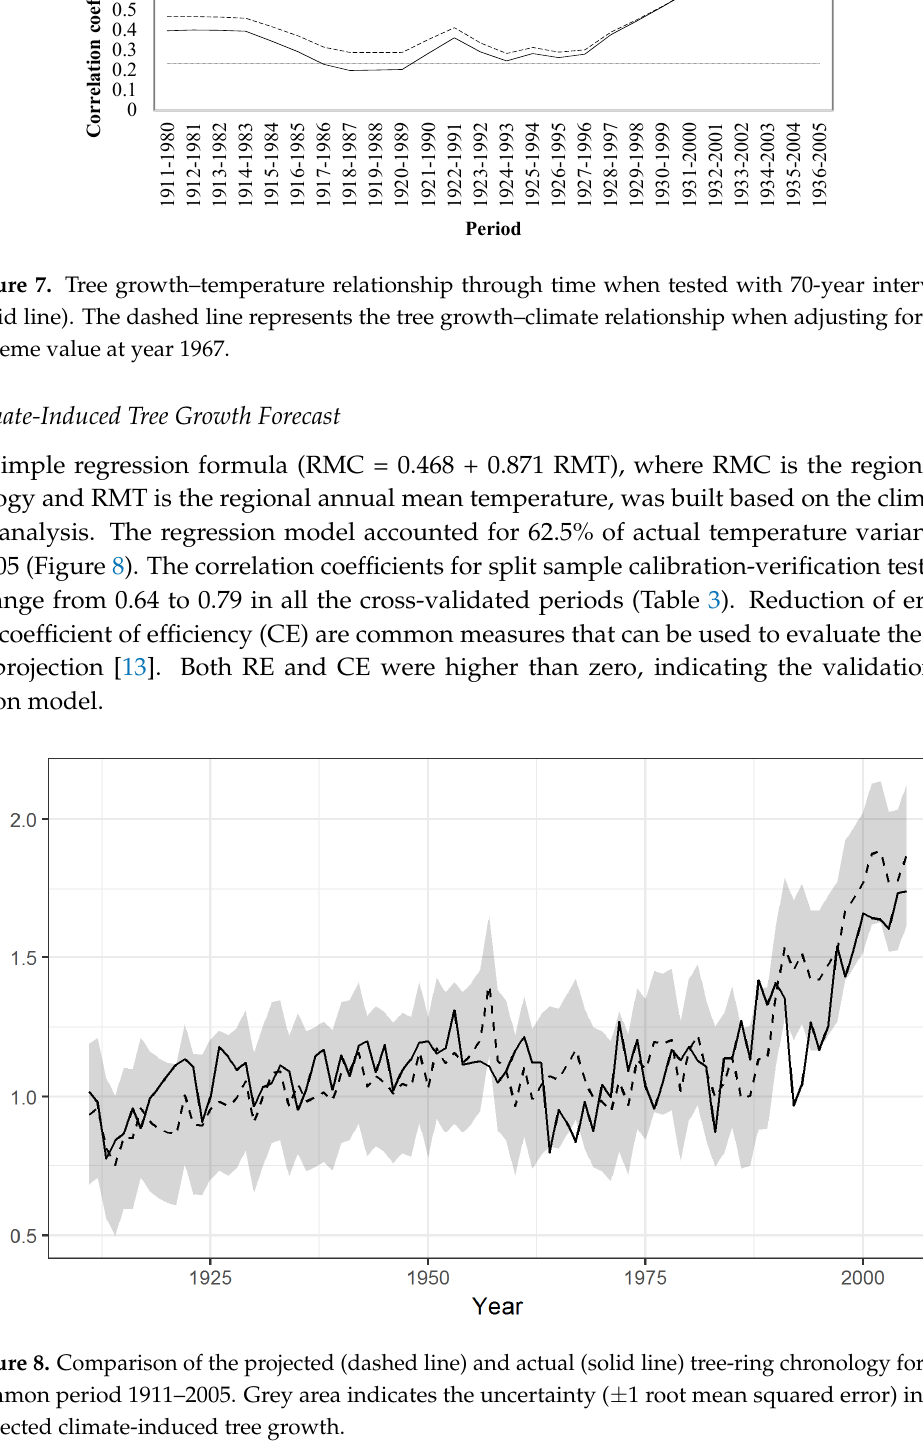
Figure 6. Correlation coefficients between regional mean signal ‐ free chronology and simulated regional mean temperature (GCMs) at each month for the common period 1911–2005.